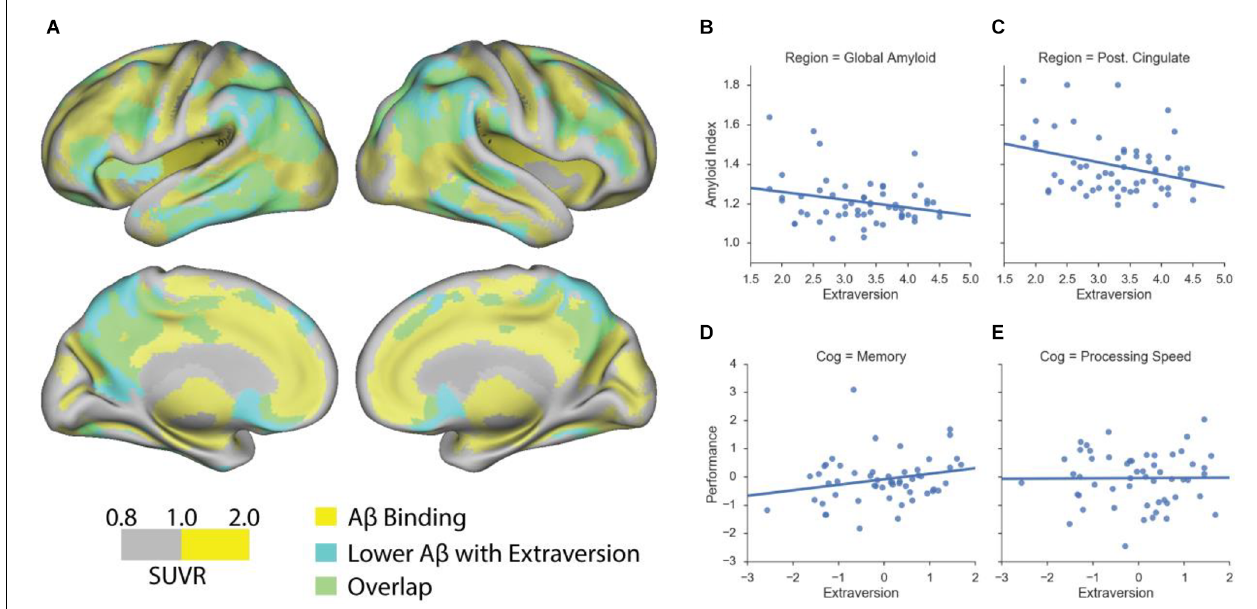
FIGURE 1 | Extraversion is associated with lower amyloid deposition in cognitively normal older adults. (A) Association between voxel-wise standardized uptake value ratio (SUVR) measures and extraversion among cognitively normal older adults. Scale represents voxel-wise SUVR measures. Regions highlighted in yellow represent voxels whose SUVR values are equal to or are greater than 1. Regions highlighted in cyan represent suprathreshold voxels showing a significant negative association between extraversion and amyloid burden. Regions highlighted in green indicate an overlap between amyloid deposition and a significant negative association with extraversion scores. (B) Extraversion scores are associated with lower amyloid deposition as quantified by a global amyloid index that represents the mean cortical amyloid burden. (C) A significant negative association between extraversion and amyloid deposition is found using the mean amyloid accumulation in posterior cingulate cortex (Post. Cingulate). (D) Extraversion scores (residual values) are associated with better, although at a trend level, memory performance (residual values) among cognitively normal older adults. (E) Extraversion scores are not associated with processing speed. Age and sex were controlled in the